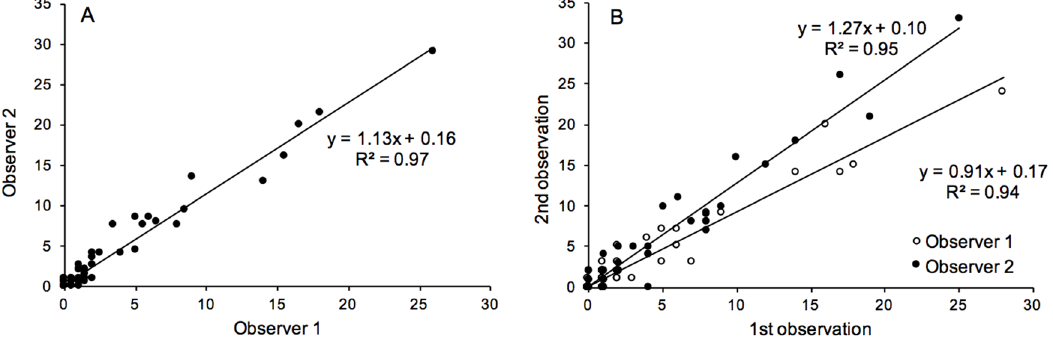
Fig 8. Examination of observerbias. Correlations of abundances of living oysters estimated from video-analyses (A) betweentwo different observers and (B) betweenreplicatereadingswithin observers(# oysters per 4 m section).